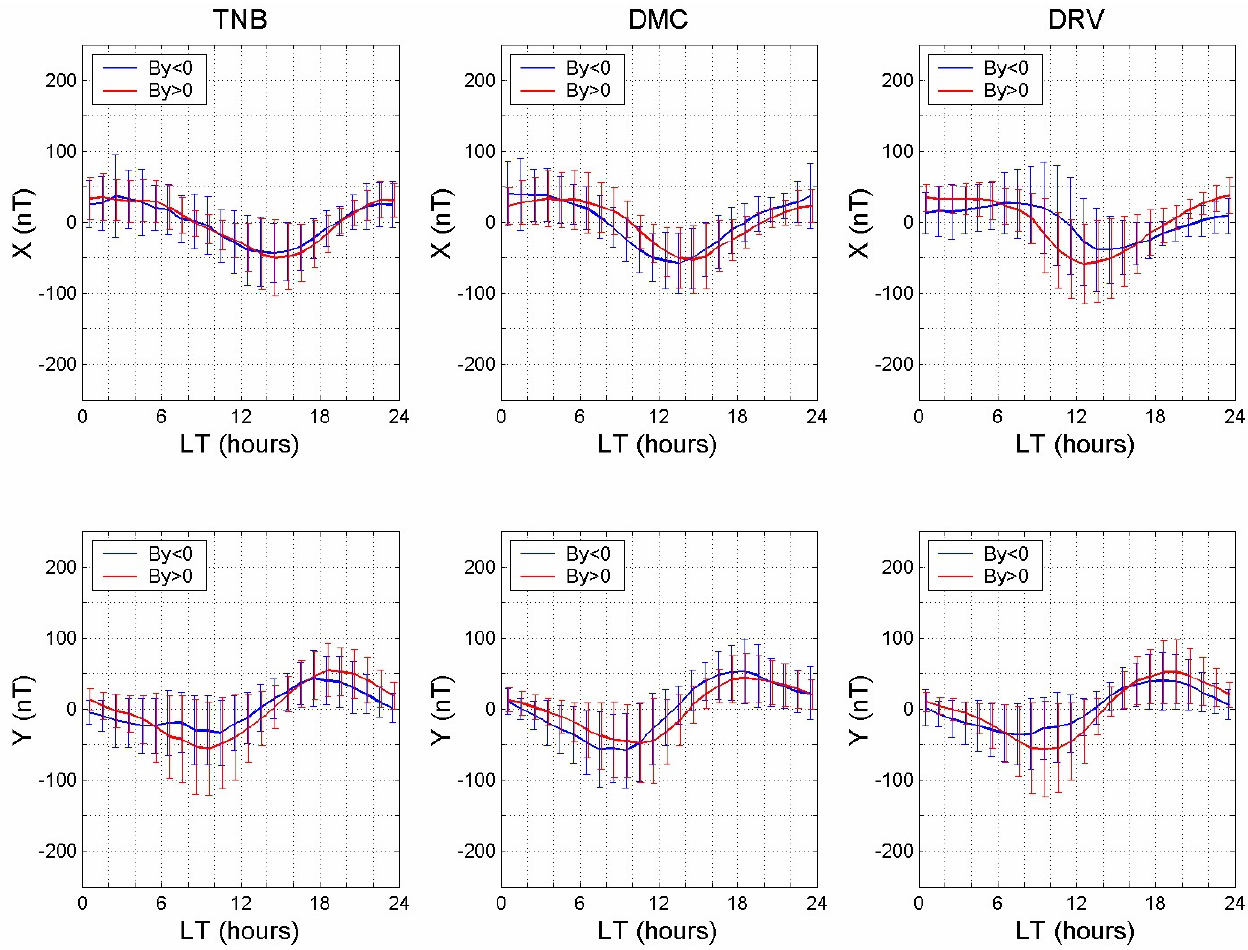
Fig. 8. Daily distribution of the average hourly values and their standard deviation for the X and Y components, separately for positive and negative B y